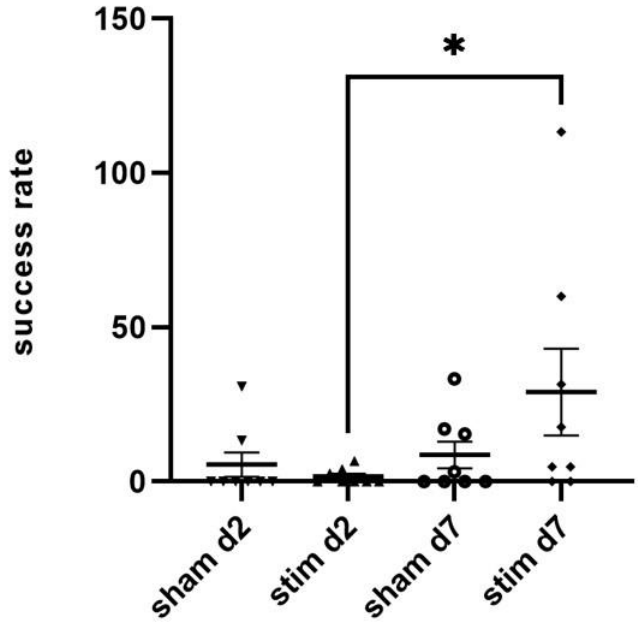
Figure 2. Single-pellet reaching test (SPRT). STN-stimulated animals showed a significant improve- ment in the SPRT on day 7 when compared with day 2 after intervention, whereas this was not seen in sham-stimulated animals. n = 8/group; Mann–Whitney U Test. Stim: stimulated animals; in sham-stimulated animals. n = 8/group; Mann – Whitney U Test. Stim: stimulated animals; sham: sham-stimulated animals. * p < 0.05.